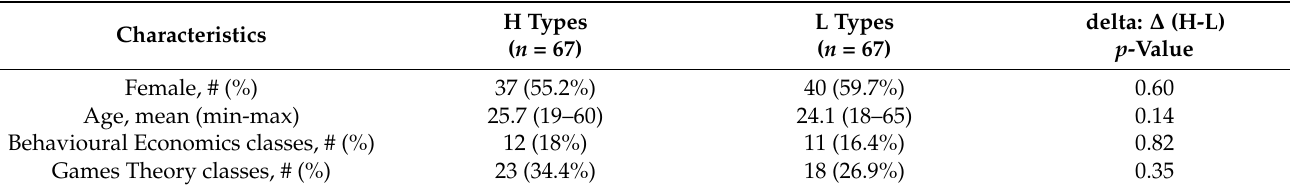
Table 2. Balance of the two experimental